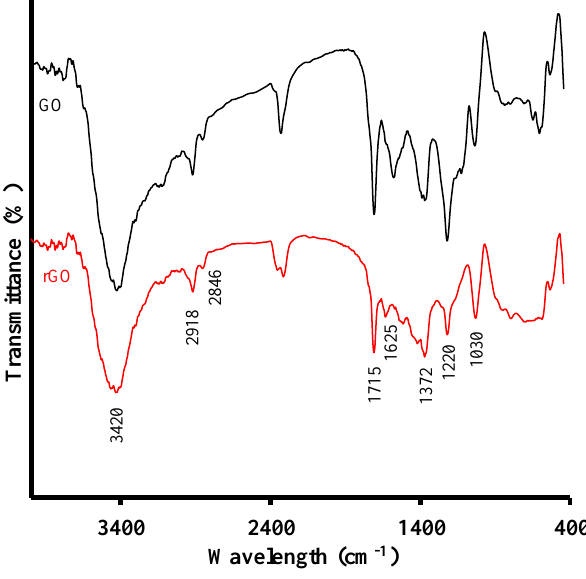
Figure 4. FTIR spectra of GO and rGO.